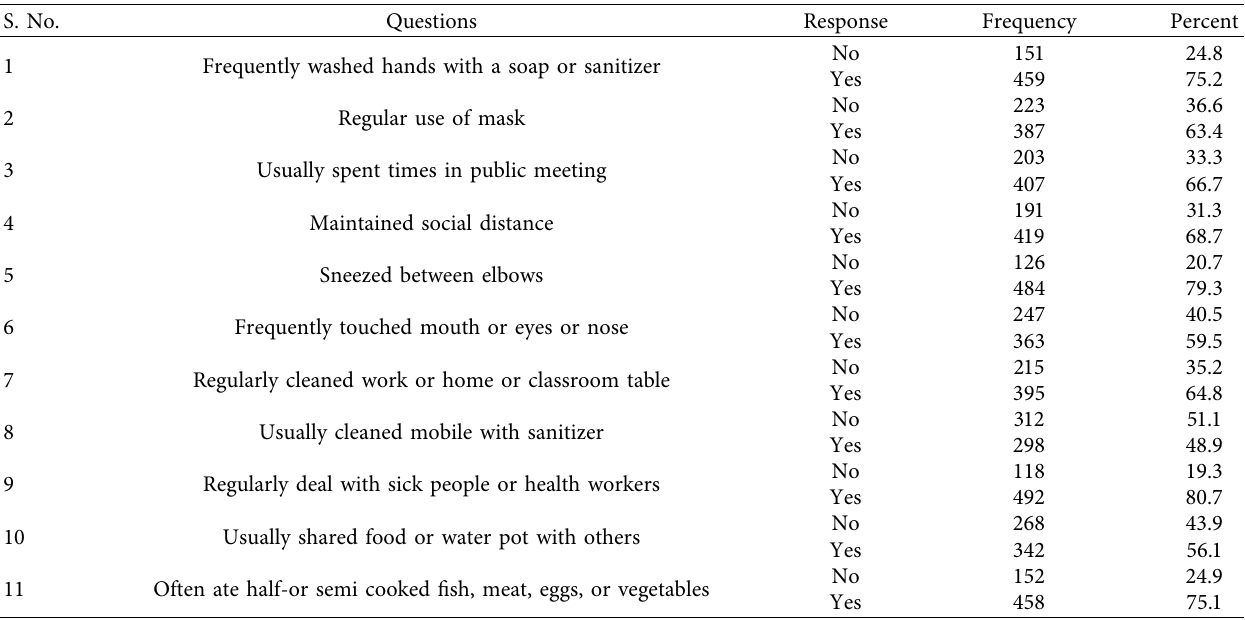
Table 5: Eleven questions to evaluate the level of practice on COVID-19 among mothers in Dessie town, Ethiopia, 2020. S.